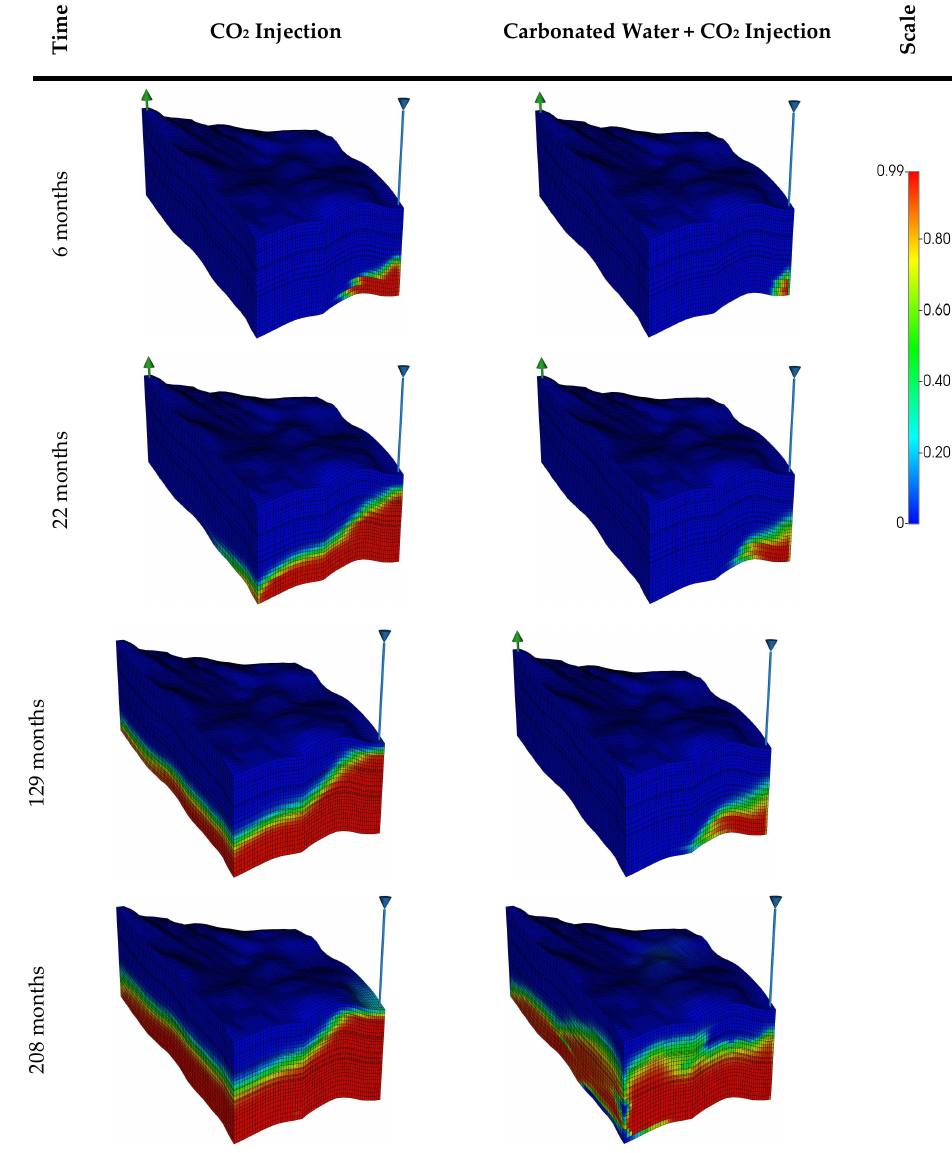
Figure 17. Global CO 2 mole fraction at different times for CO 2 injection only (left) and carbonated water combined with CO 2 injection (right). The time is given in months since injection began.